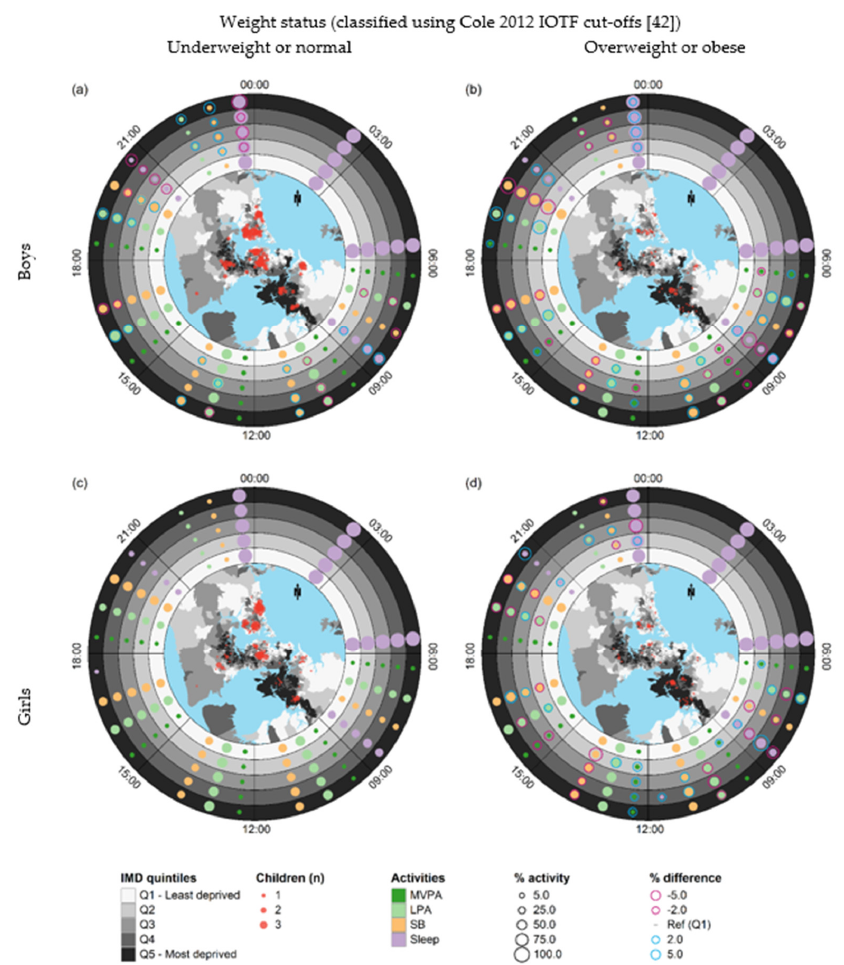
Figure 3. Small-multiple ringmaps comparing time-use patterns on weekdays for children who regularly actively travelled to school in association with deprivation by sex and weight status: ( a ) boys with underweight or normal status; ( b ) boys with overweight or obese; ( c ) girls with underweight or normal status; ( d ) girls with overweight or obese status. The configuration of each ringmap is the same as the ringmap in Figure 2. Proportional circular outlines representing negative and positive differences in average percentage of time spent on each activity compared to the least deprived quintile (% difference = 0%) are overlaid. Percentages of less than 1% and differences in percentages between −2% and 2% are suppressed.